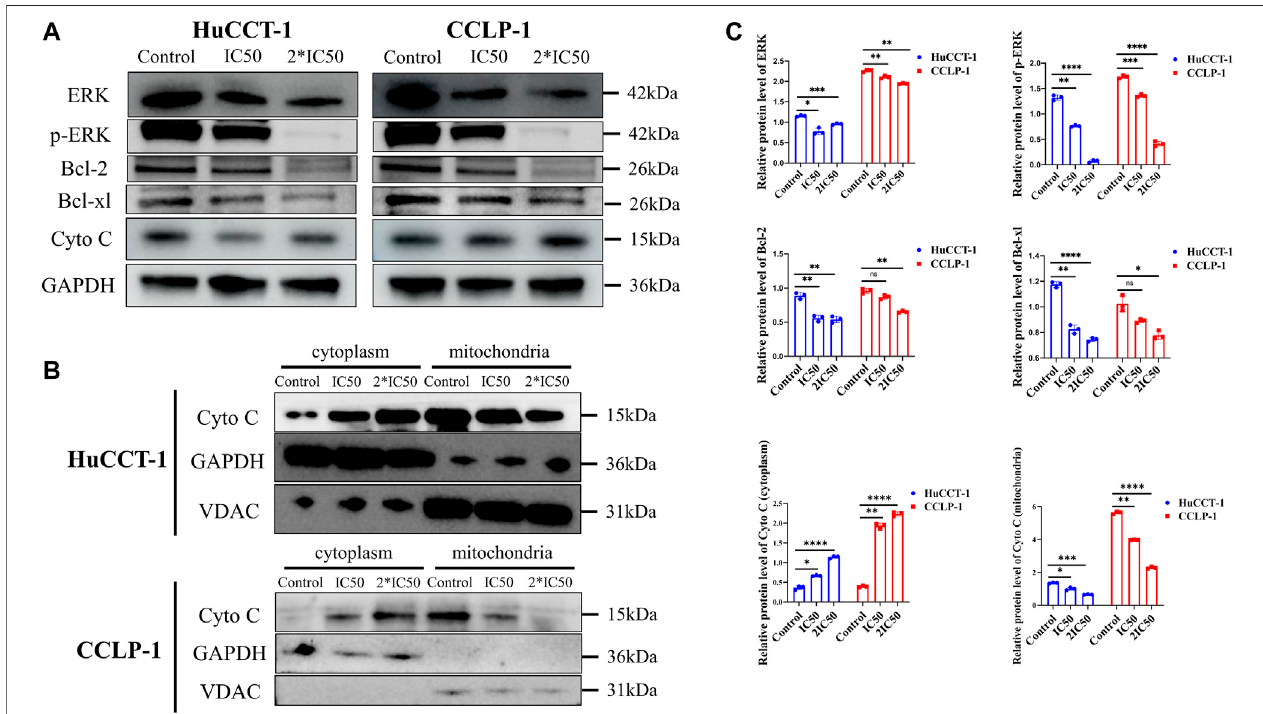
FIGURE 4 | Silibinin induced apoptosis of cholangiocarcinoma cells through the ERK/Cytochrome c pathway. (A) . Expression of upstream proteins of the mitochondrial apoptosis pathway, as detected by western blotting. Cells were treated with IC50 and 2*IC50 concentrations of silibinin for 48 h (B) . Cytochrome C expression in different parts after mitochondrial isolation. (C) . The quanti fi cation results of western blotting. Data are shown as mean ± SD, * p < 0.05 , ** p < 0.01 , *** p < 0.001 , **** p < 0.0001 , signi fi cantly different compared to the control